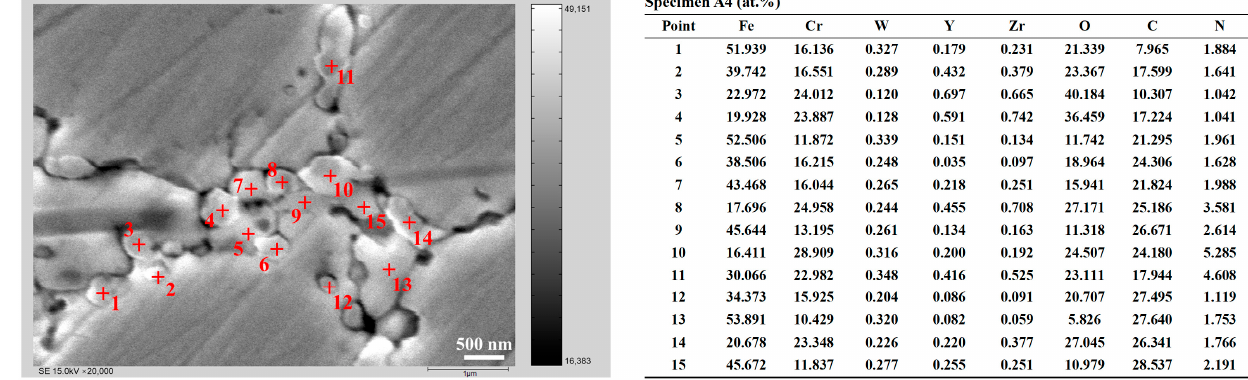
Figure 15. EPMA results of specific compositions of some typical precipitates in specimen A4.